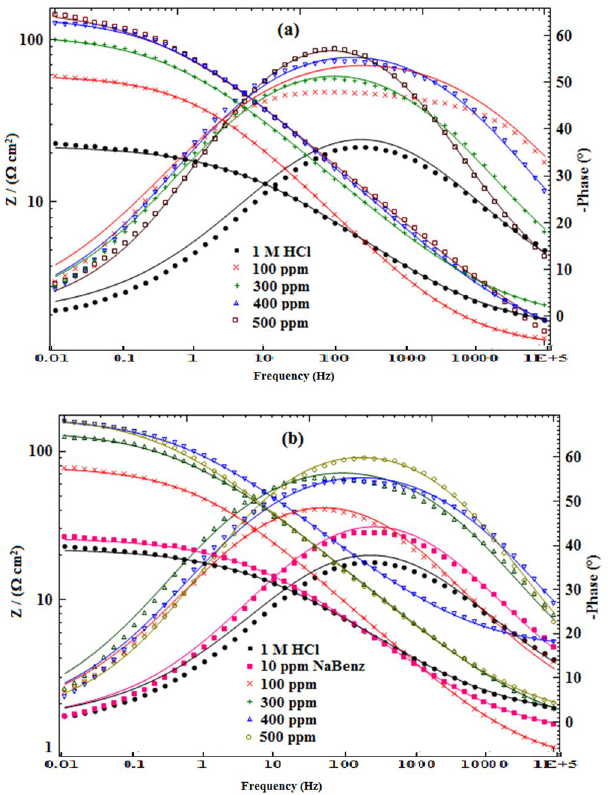
Figure 5. Bode plots of MS in 1M HCl solution without and with different concentrations of inhibitors ( a ) LPr and ( b ) LPr + 10 ppm